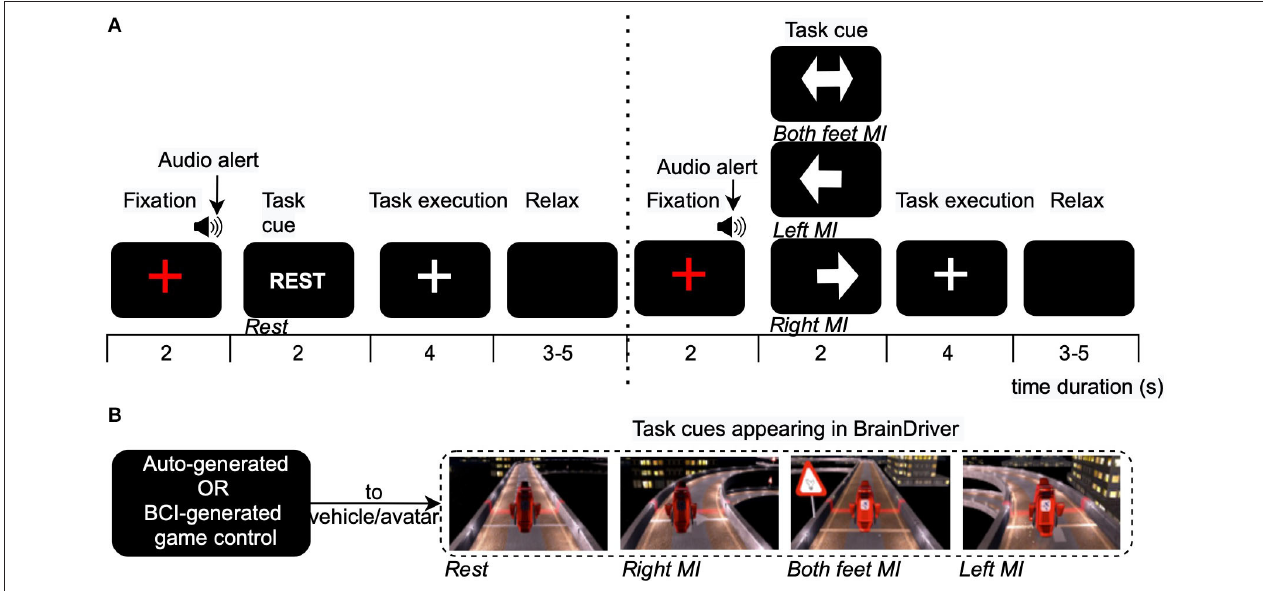
FIGURE 1 | Timeline and experiment interface under different calibration paradigms. (A) Arrow-based calibration paradigm ( aC ): The conventional MI-BCI interface is modified to include a “REST” trial prior to every motor task. The visual cues presented to the pilot and the associated instruction is illustrated. (B) Game-based calibration paradigm ( gC ) and game-based evaluation paradigm ( gE ): The BrainDriver interface is used to deliver visual cues. In gC , the game control is automatically generated by a program which replicates the expected input to control the game accurately. In gE , the BCI controls the game in real-time. In both these paradigms, the pilot is instructed to generate relevant brain activity to play the game. The white horizontal line across the track, in the snapshots, depicts the beginning of the next MI zone.